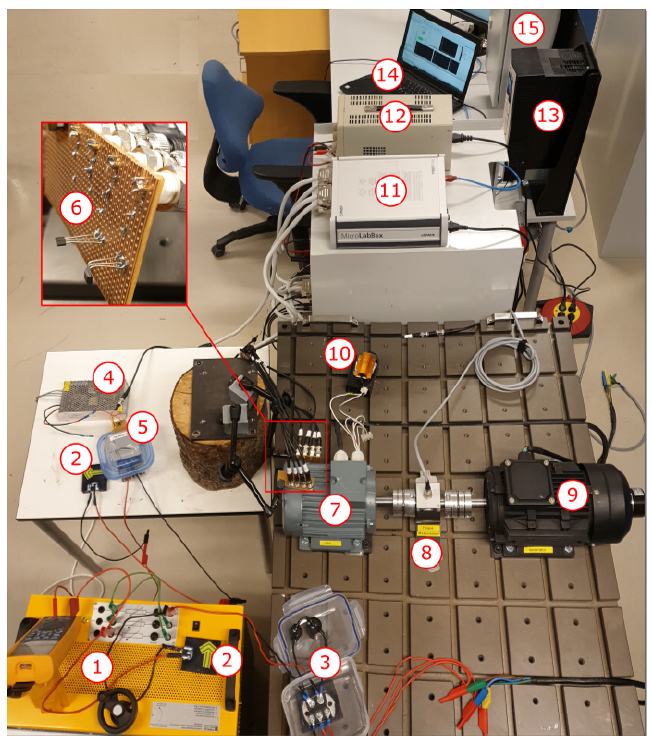
Figure 8. Schematic diagram of test bench.